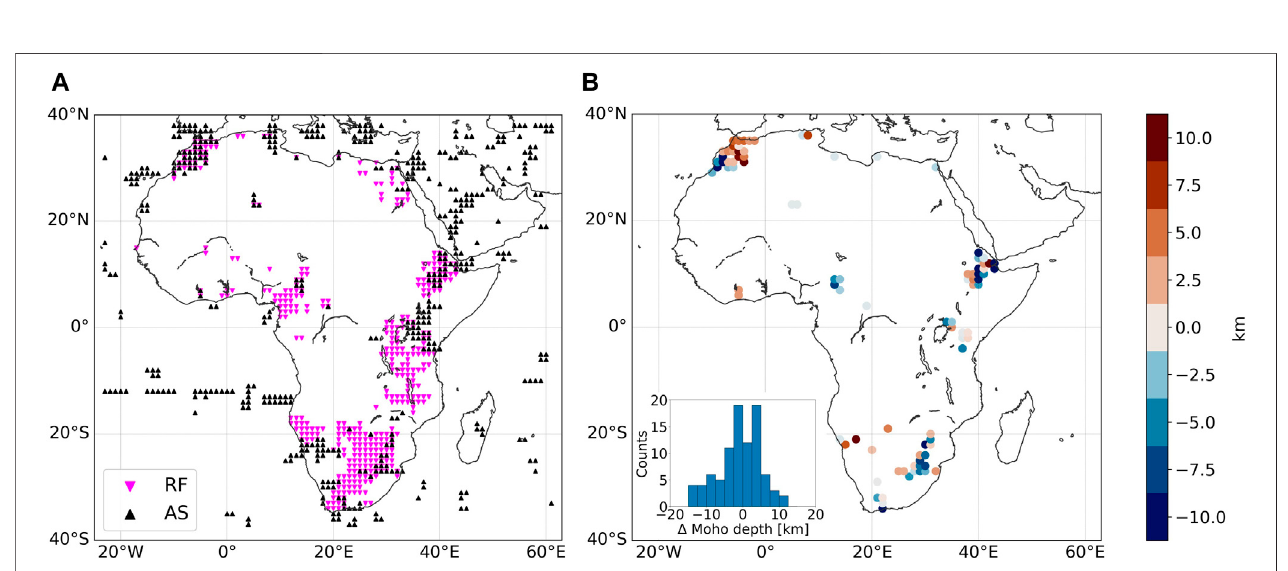
FIGURE 2 | Location of the seismic stations, binned on a 1 ° grid. (A) Active source seismic estimates (AS), marked as black triangles, and receiver functions (RF), marked as pink inverted triangles. (B) Differences of AS and RF estimates at overlapping stations. Red colours indicate deeper RF estimates, blue colours deeper AS estimates. The inset histogram shows the cumulative